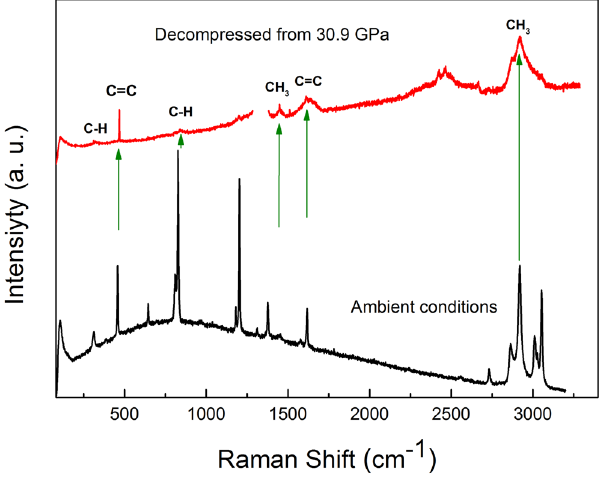
Figure 8. The Raman spectrum of the p -xylene at ambient conditions and decompressed from 30.9 GPa.